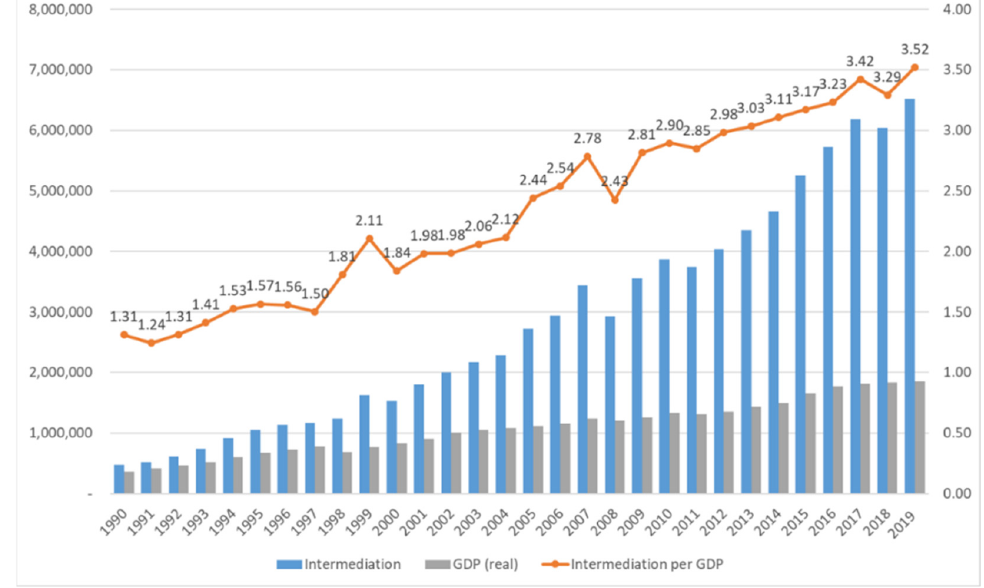
Figure 3. Intermediated asset over GDP. Source: (Bank of Korea 2020; The World Bank 2021).